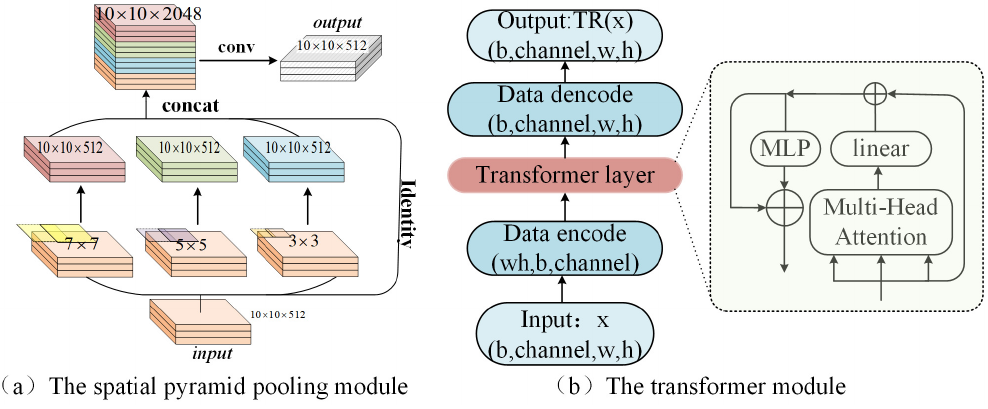
Figure 10. The structure of SPP module ( a ) and transformer ( b ).